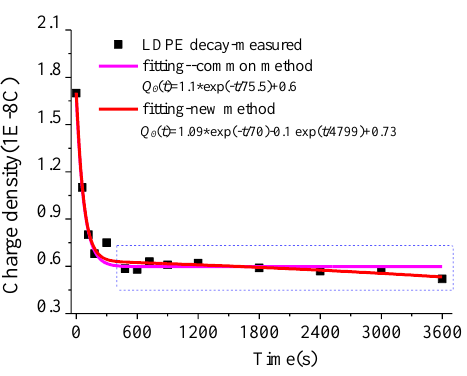
Figure 10. Charges decay analysis for the low density polyethylene (LDPE) sample applied 4 kV for 10 min (charges data was derived from [16]).